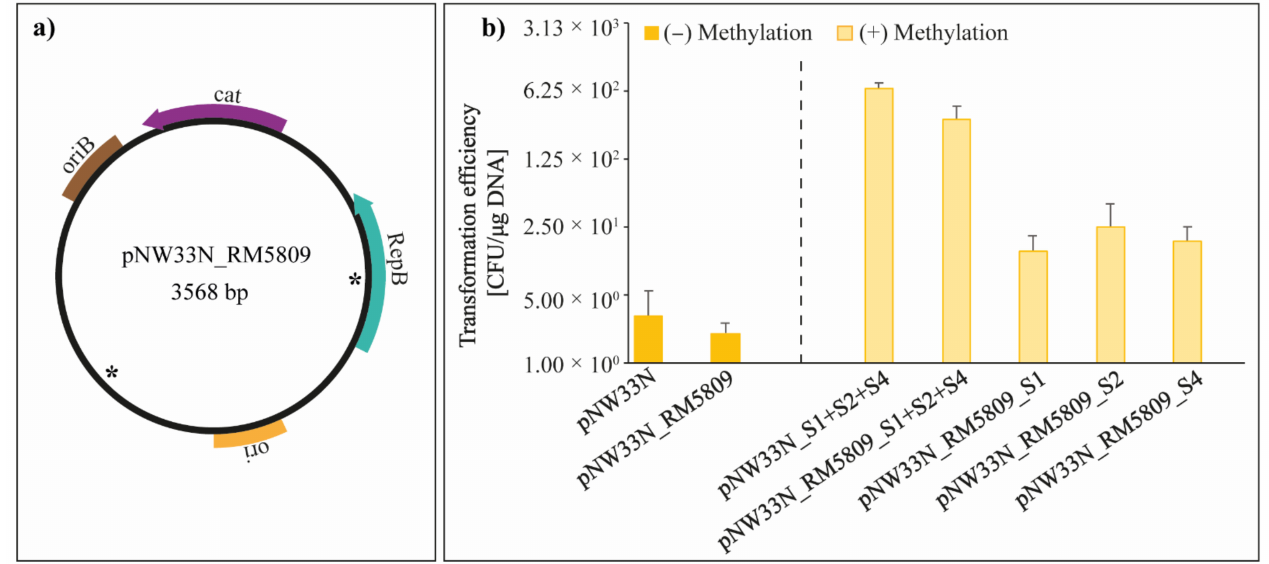
Figure 3. Strategies to enhance transformation efficiency by breaking the restriction barriers. ( a ) Schematic illustration of plasmid pNW33N_RM5809 with mutated RM recognition sites marked (*); ori–pUC19 origin of replication for plasmid propagation in E. coli; oriB–pNW33N origin of repli- cation for plasmid propagation in P. thermosuccinogenes ; repB –replication protein for pNW33N origin of replication; cat –chloramphenicol acetyl-transferase, provides resistance to chloramphenicol and thiamphenicol. ( b ) Transformation efficiency of P. thermosuccinogenes using the plasmids pNW33N and pNW33N_RM5809 isolated from modified E. coli HST04 strains consisting of all methylation patterns. Values represent the mean and the standard deviation of three independent plasmid DNA isolations that were used for each